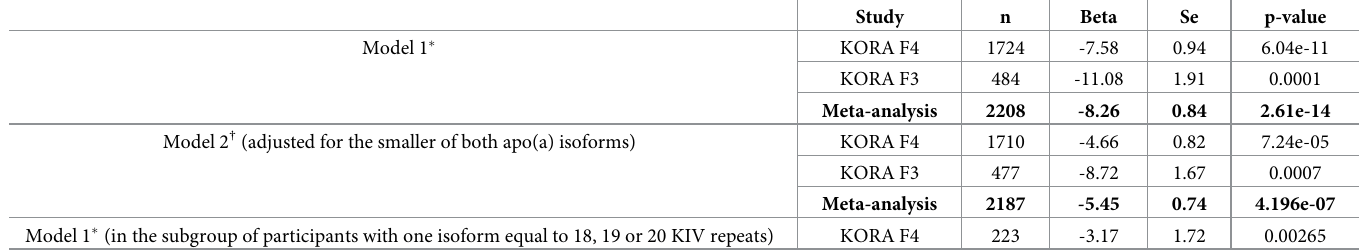
Table 1. Results of the linear model of cg site cg17028067 on Lp(a).